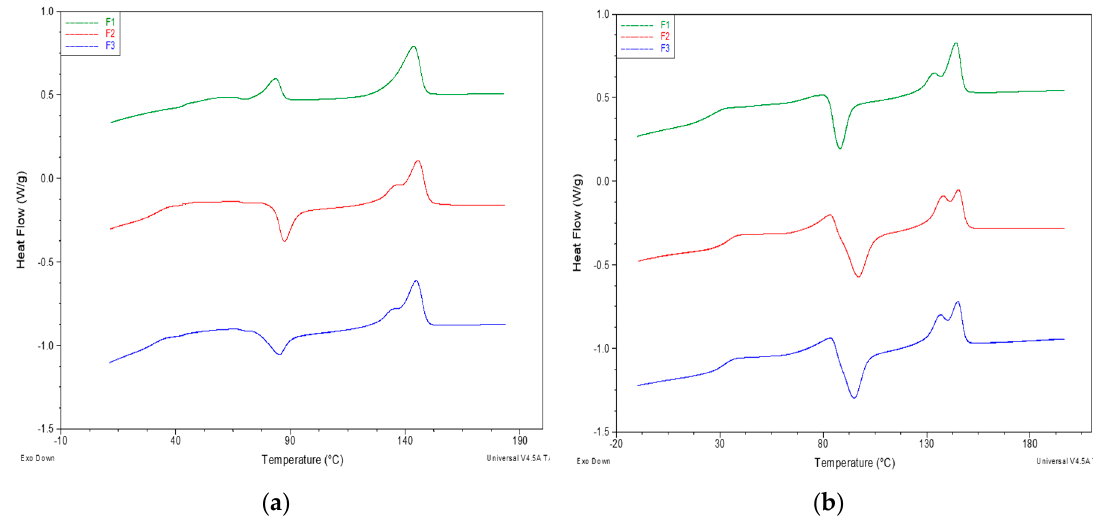
Figure 6. DSC heating thermograms of F1, F2 and F3: ( a ) First heating; ( b ) second heating. Exothermal peaks are oriented down.